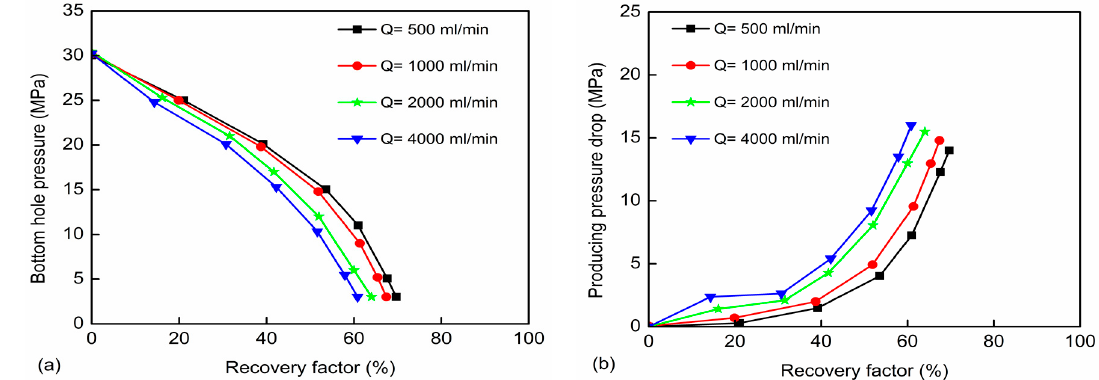
Figure 6. Bottom hole pressure and producing pressure drop versus recovery factor for different production rates. ( a ) Bottom hole pressure; ( b ) producing pressure drop.